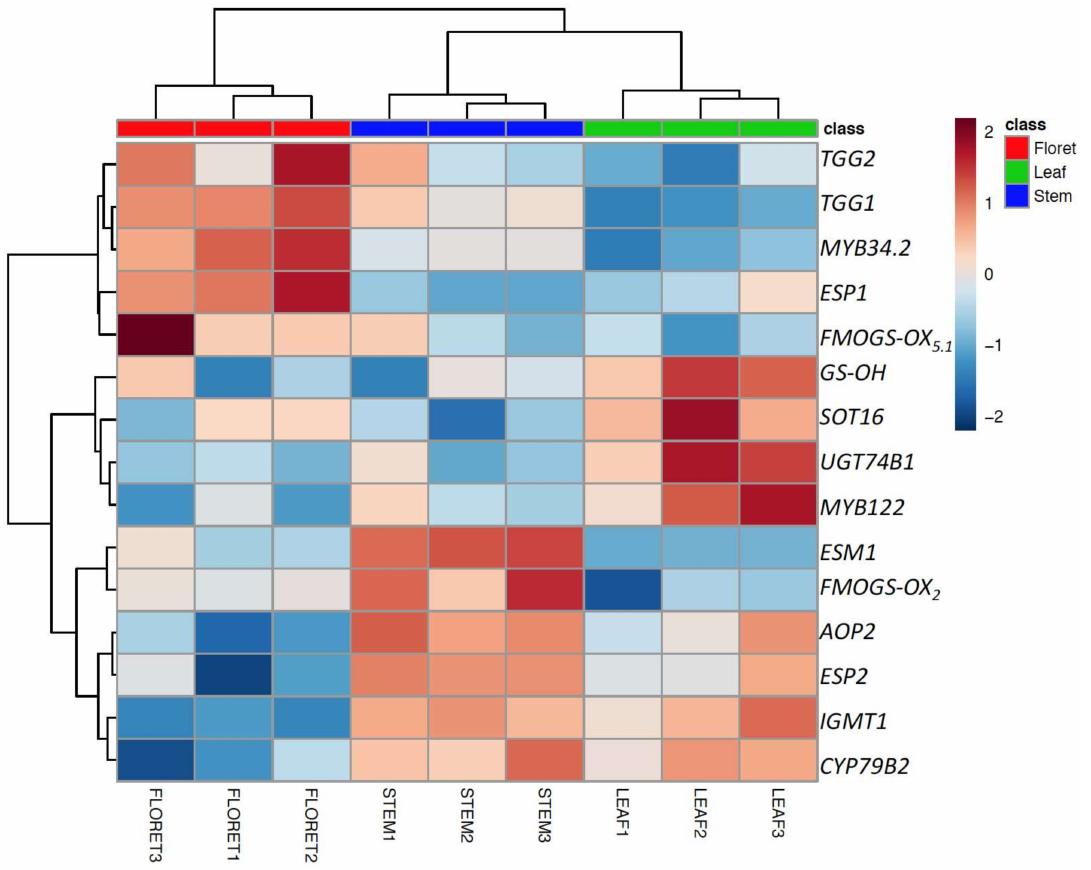
Figure 4. Top 15 significantly expressed genes (glucosinolate biosynthesis, myrosinase, cofactors genes) among the different broccoli tissues. The gene expression values were normalized based on mean value of floret and then transformed to logarithmic